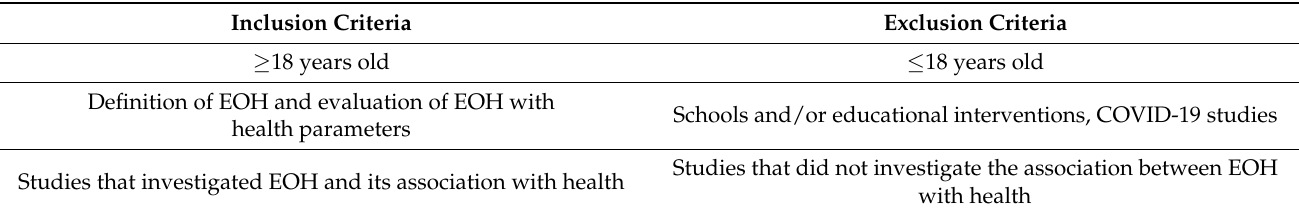
Table 1. Data extraction and criteria for the evaluation of the included